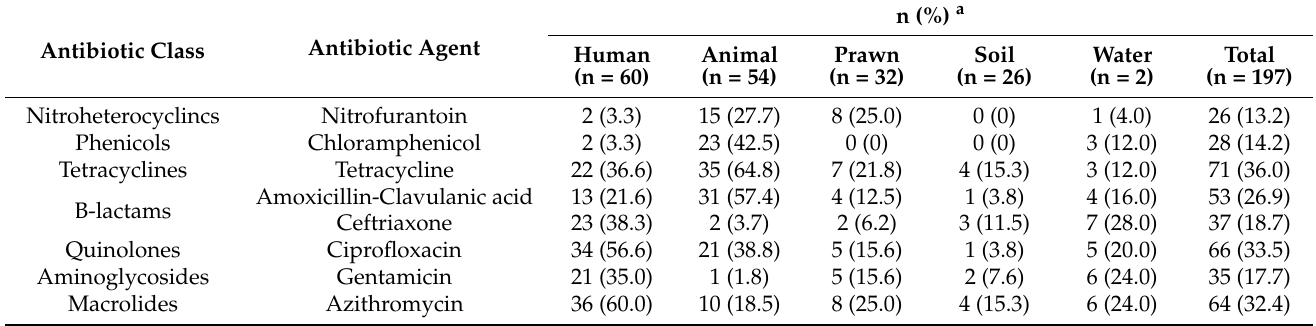
Table 2. Antibiotic resistance phenotype of E. coli isolated from different samples.